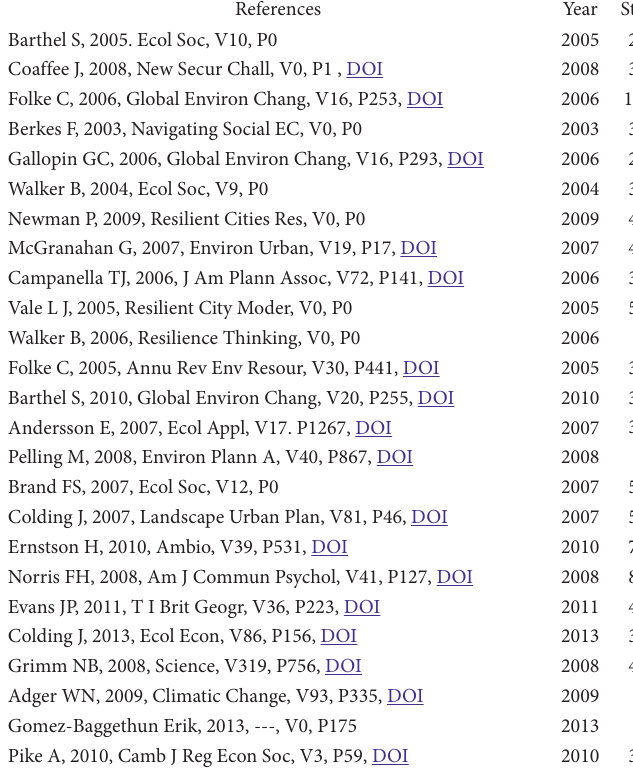
Figure 3: Top 25 references with strongest citation